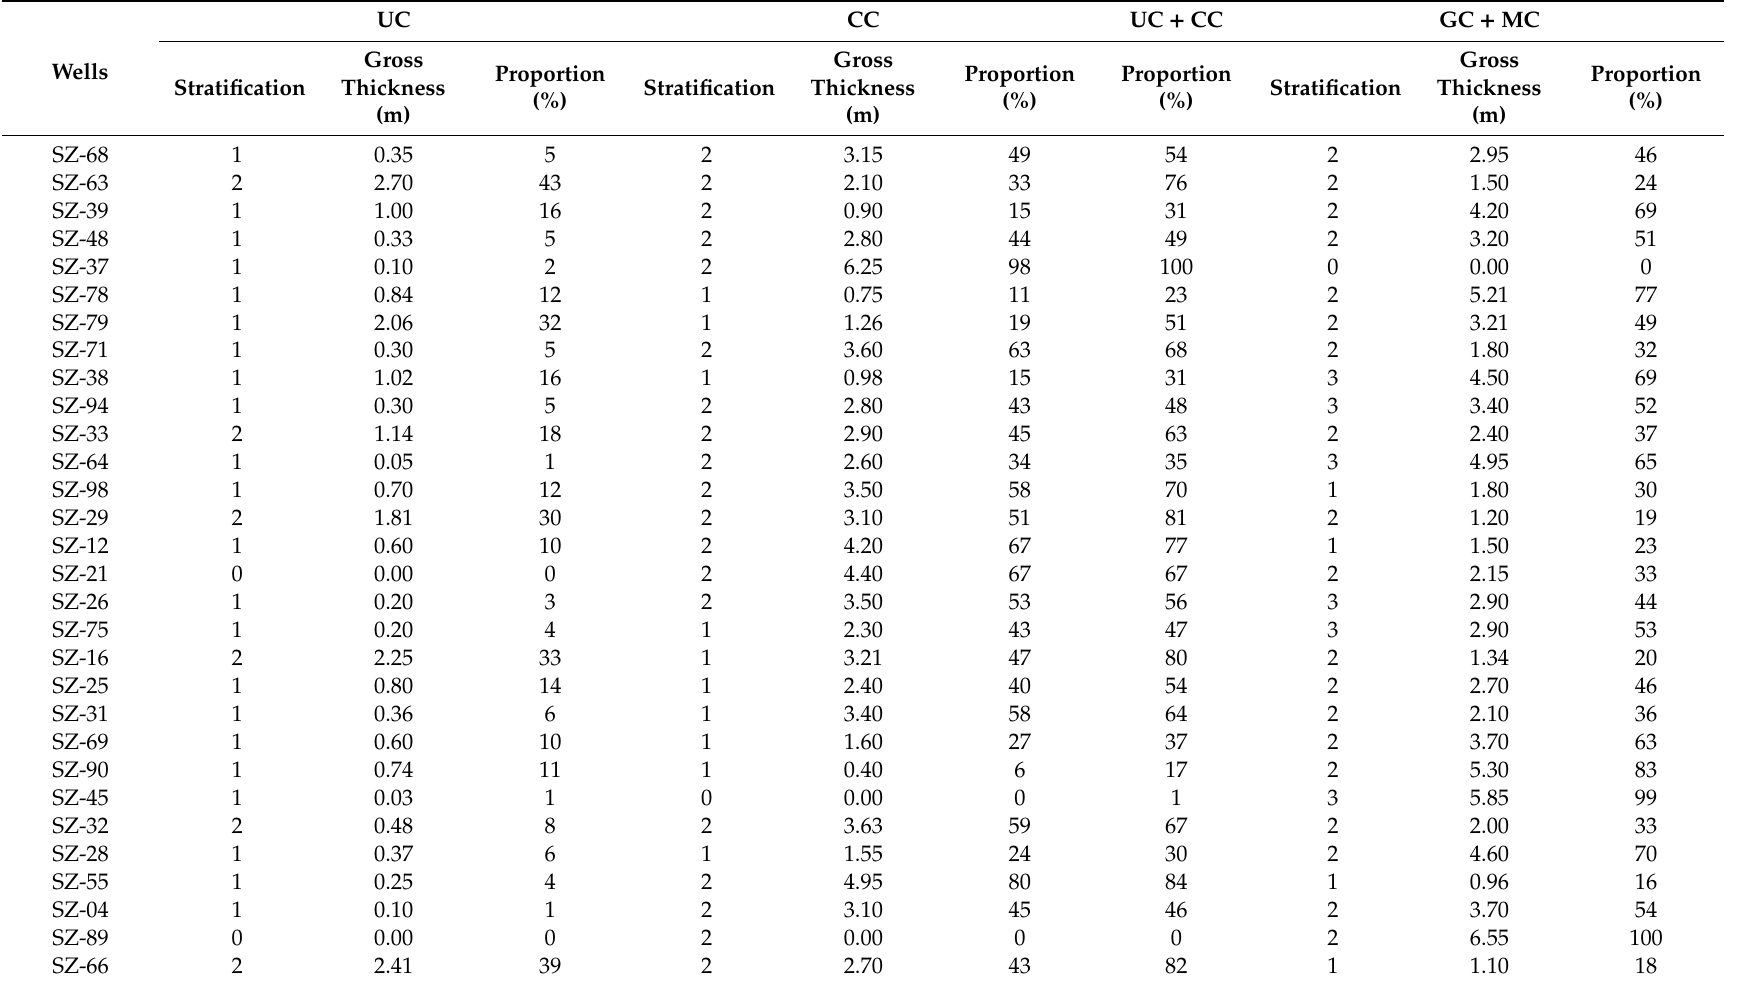
Table 1. Thickness and proportion of di ff erent coal structure in coal